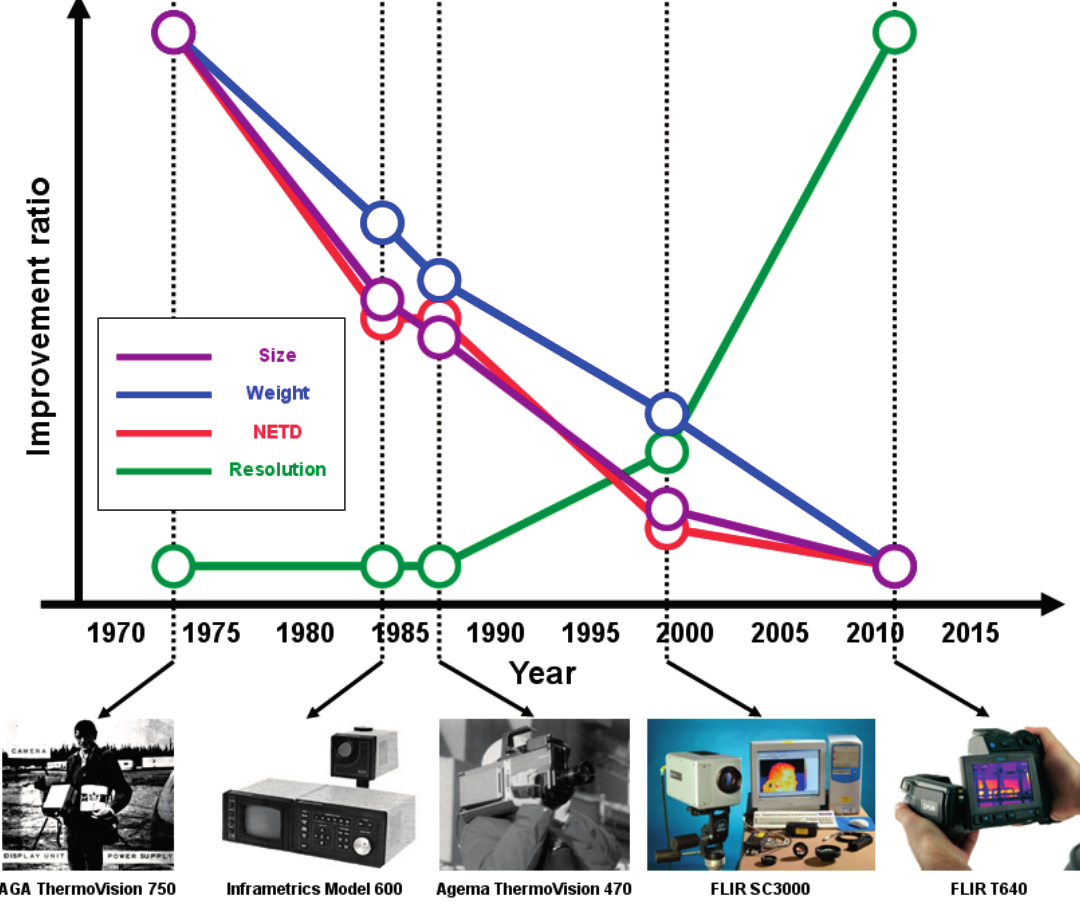
Figure 1. Relative improvement in some representative thermal imaging systems spanning from the year 1970 to